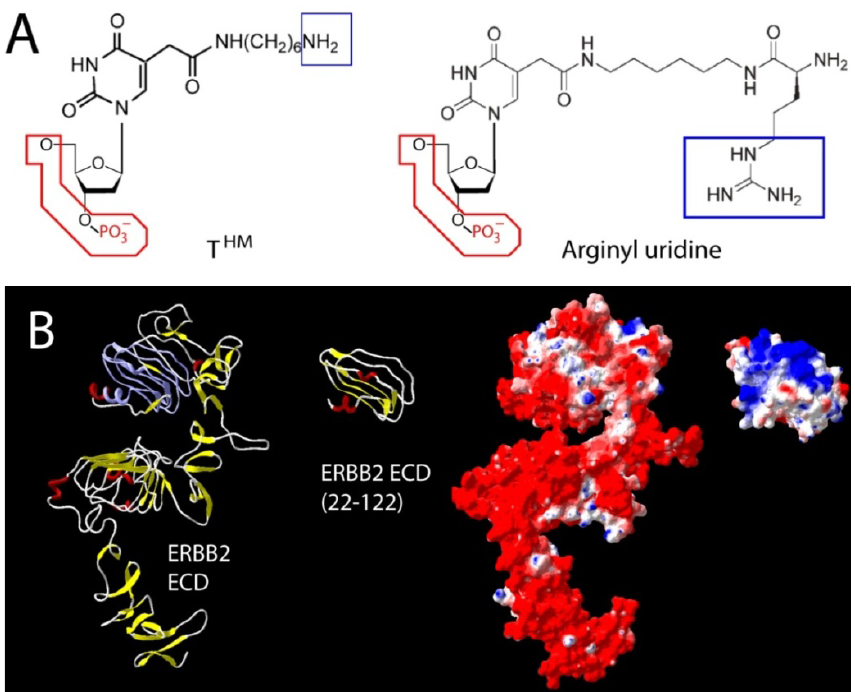
Figure. 3. Two different approaches used to counteract charge repulsion of nucleic acid aptamers. ( A ) T HM (5- N -(6-aminohexyl) carbamoylmethy-2- O -deoxyuridine) and arginyl uridine represent two modified bases that can be enzymatically incorporated. This approach yielded aptamers against Silalyllactose [66] (T HM ), or glutamic acid [80] and carboxy glutamic acid [81] respectively (arginyl-uridine); ( B ) Aptamer selection against the extracellular domains of ERBB2 (HER2) has been challenging due to its uniformly distributed negative surface charge (red in surface representation). In the absence of its extreme N- and C -terminal capping regions, a segment (22–122) of domain one provided suitable bait for the selection of a nanomolar RNA aptamer. Once selected, the final 2' Fluoro RNA aptamer retains its high affinity in vitro and in vivo in the presence of surrounding negative surface charges [79]. Truncations and surface charge calculations of the reference structure for ERBB2 [82] were generated in Swiss PDB viewer using default